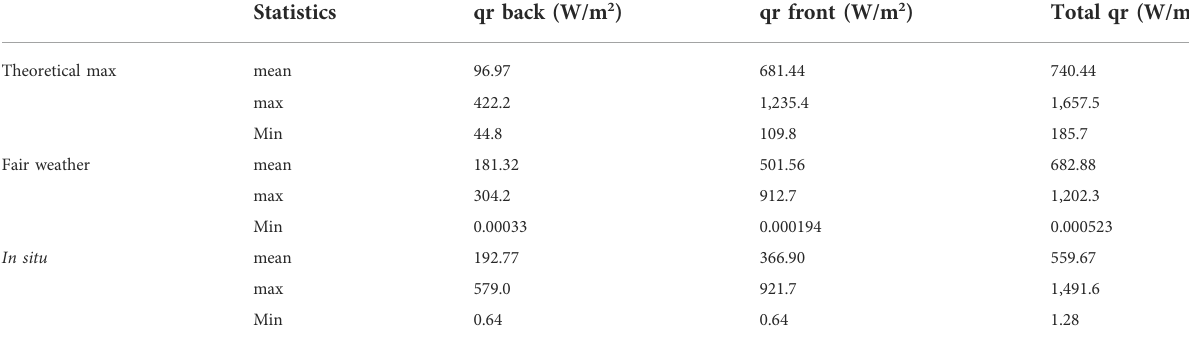
TABLE 4 Statistical properties of radiative transfer for different